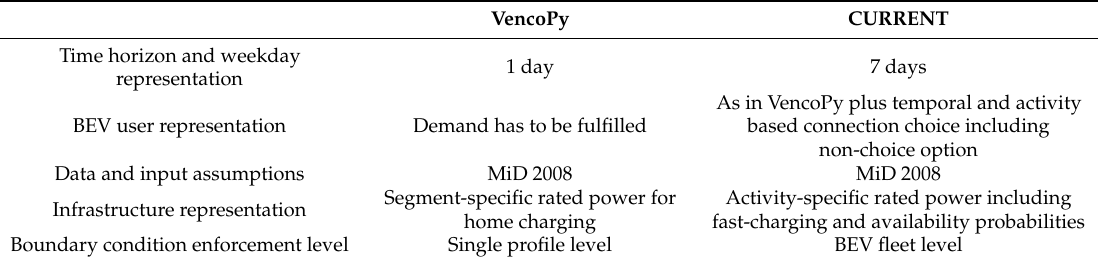
Table 1. Main di ff erences between the BEV charging representation in VencoPy and